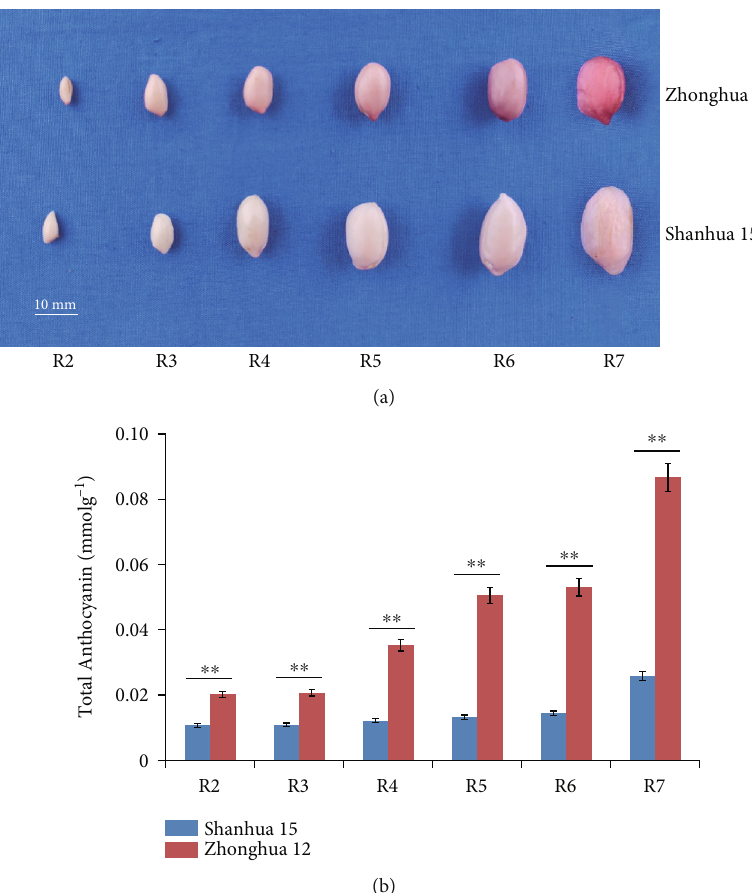
Figure 1: Phenotypic characterization of peanut testa at di ff erent developmental stages. (a) The phenotype of Arachis hypogaea cv.Zhonghua12 and Shanhua15 seed kernel from R2 to R7 stages. (b) Changes in anthocyanins during Shanhua15 and Zhonghua12 testa